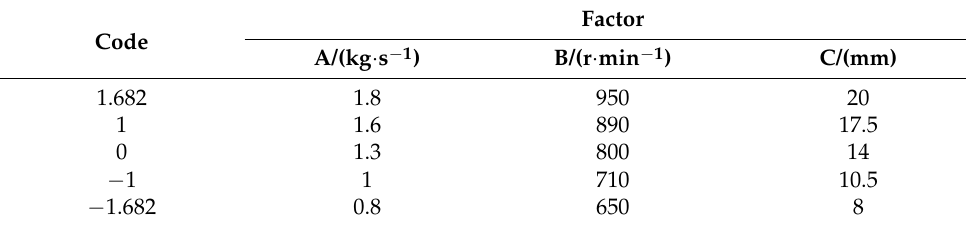
Table 2. Coad of factor level.